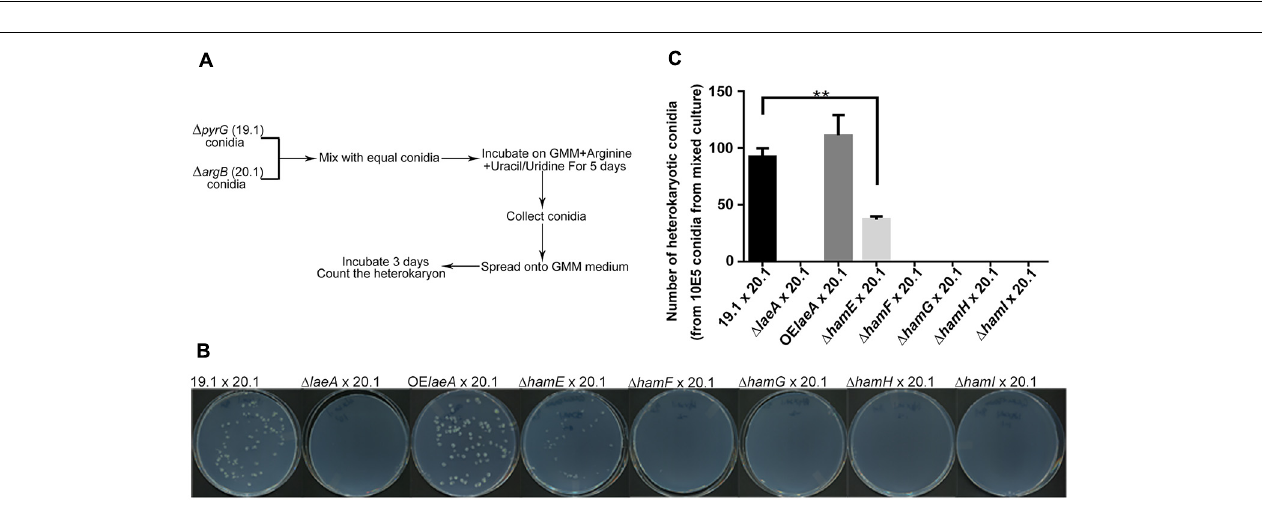
FIGURE 3 | Hyphal fusion of ham mutants. (A) . Outline of the method to measure hyphal fusion in Aspergillus oryzae (Tsukasaki et al., 2014) which was modified for this work. (B) Photographs of heterokaryon formation or lack of formation in crosses. Plates of mixed cultures were spread and incubated at 29 ◦ C for 3 days. (C) The number of heterokaryotic colonies formed for each cross. ∗∗ P < 0.01. (cid:49) laeA (TXZ15.1), OE laeA (TXZ16.1), (cid:49) hamE (TXZ5.2), (cid:49) hamF (TXZ6.2), (cid:49) hamG (TXZ7.2), (cid:49) hamH (TXZ8.1) and (cid:49) hamI (TXZ9.16) were uracil/uridine auxotrophic. 19.1 (TJES19.1), uracil/uridine auxotrophic. 20.1 (TJES20.1), arginine